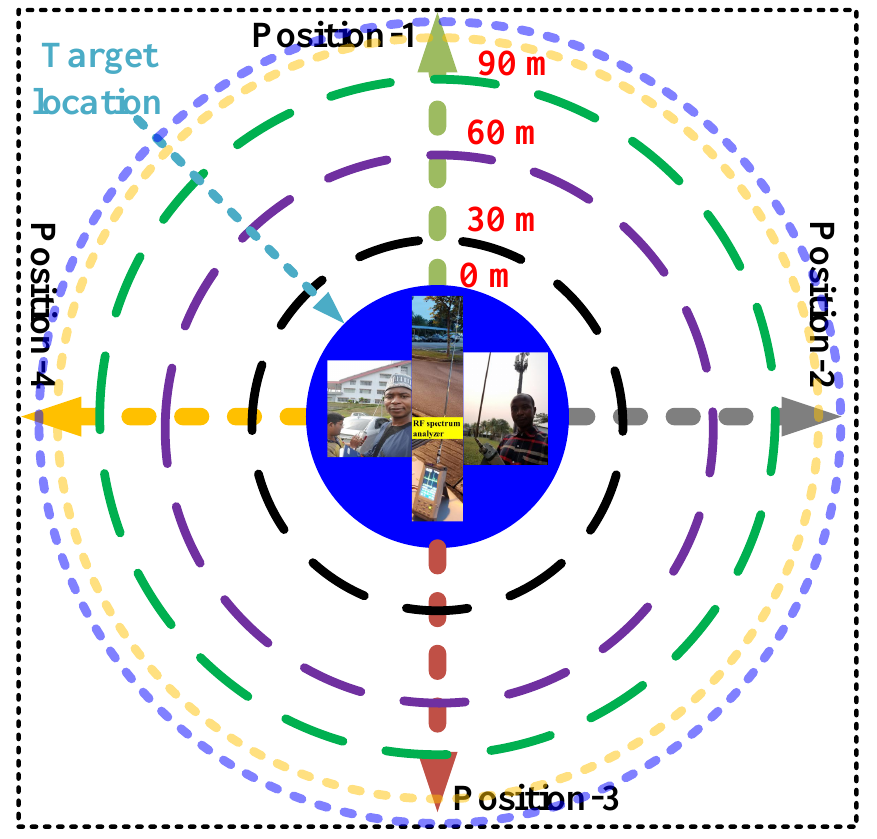
Figure 3. Strategic demarcation of the RF spectral survey at Multimedia University, Cyberjaya campus. Each sample point interval is recorded, and the average result is calculated for each span along a straight-line path. The four sectors were all subjected to a similar computa- tion. This task was repeated for all the measured data. Table 2 summarizes the received ambient RF power and its corresponding averages for the five major operating bands in the institution. It can be observed from Table 2 that the intercepted power levels at the BS are one or two orders of magnitude higher than the mobile power levels across the GSM/900, GSM/1800, and UMTS/2100, and Wi-Fi/2.45 spectrum. These four frequency bands recorded the highest average power of –21.2, –15.3, –22.5, and –17.7 dBm, respec- tively. In addition, the capability of the LTE/2600 frequency at –23.8 dBm makes it another suitable candidate for the RF harvesting. As a result, the deployment of the RF harvester in a strategic area around BSs is preferable for better performance. Therefore, the potential of these five operating bands becomes the prime focus of the RF harvester design in this